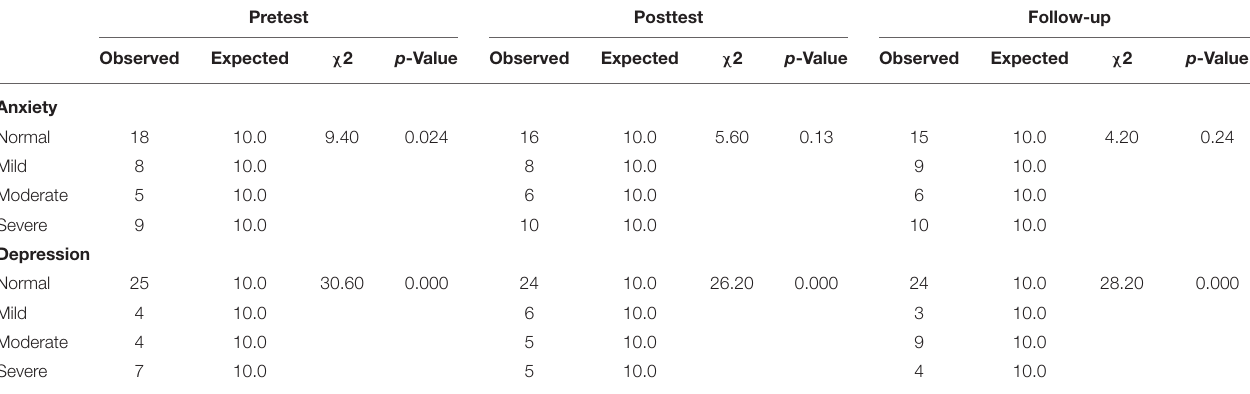
TABLE 1 | For baseline data chi square analysis between level of anxiety and depression pretesting phase (T-0), posttesting phase (T-1), and follow-up phase (T-2) in Pakistan students during COVID-19 epidemic lockdown ( N = 40). Pretest Posttest Follow-up